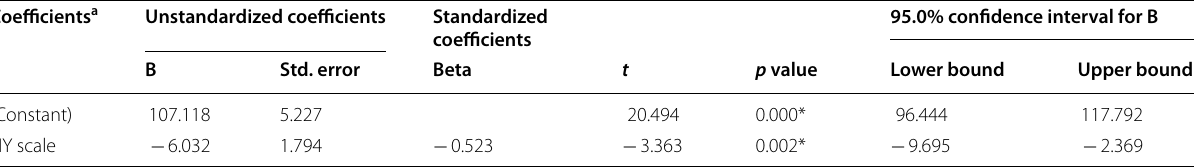
HY Hoehn and Yahr a Dependent variable: average GCC thickness